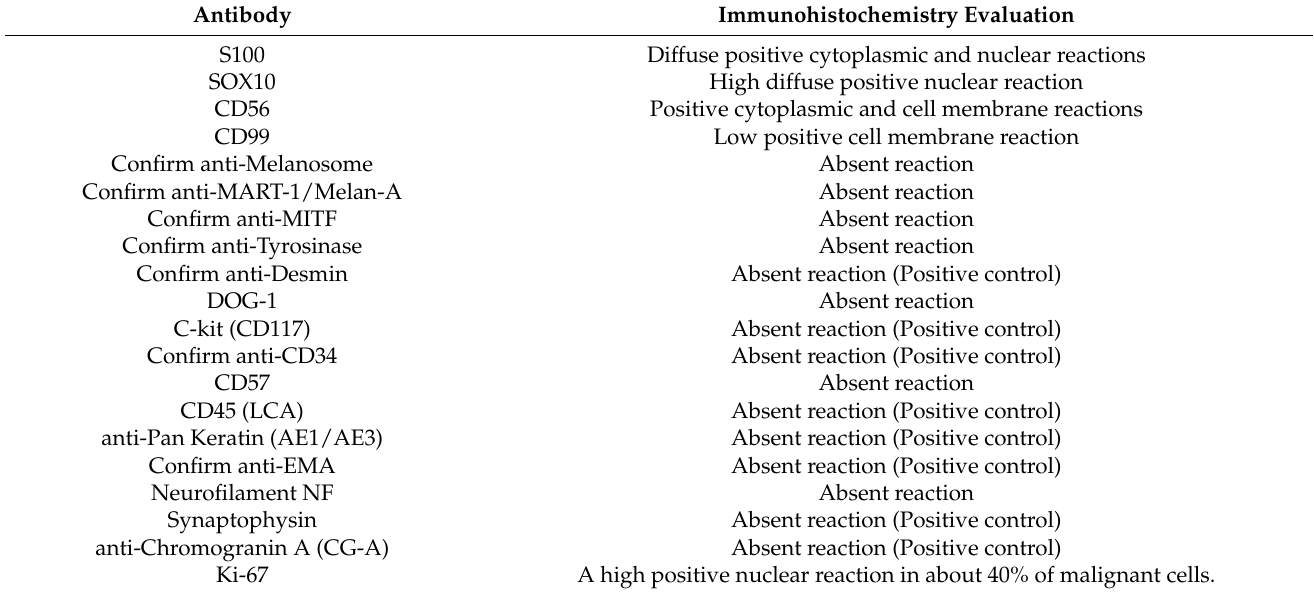
Table 2. The results of immunohistochemistry